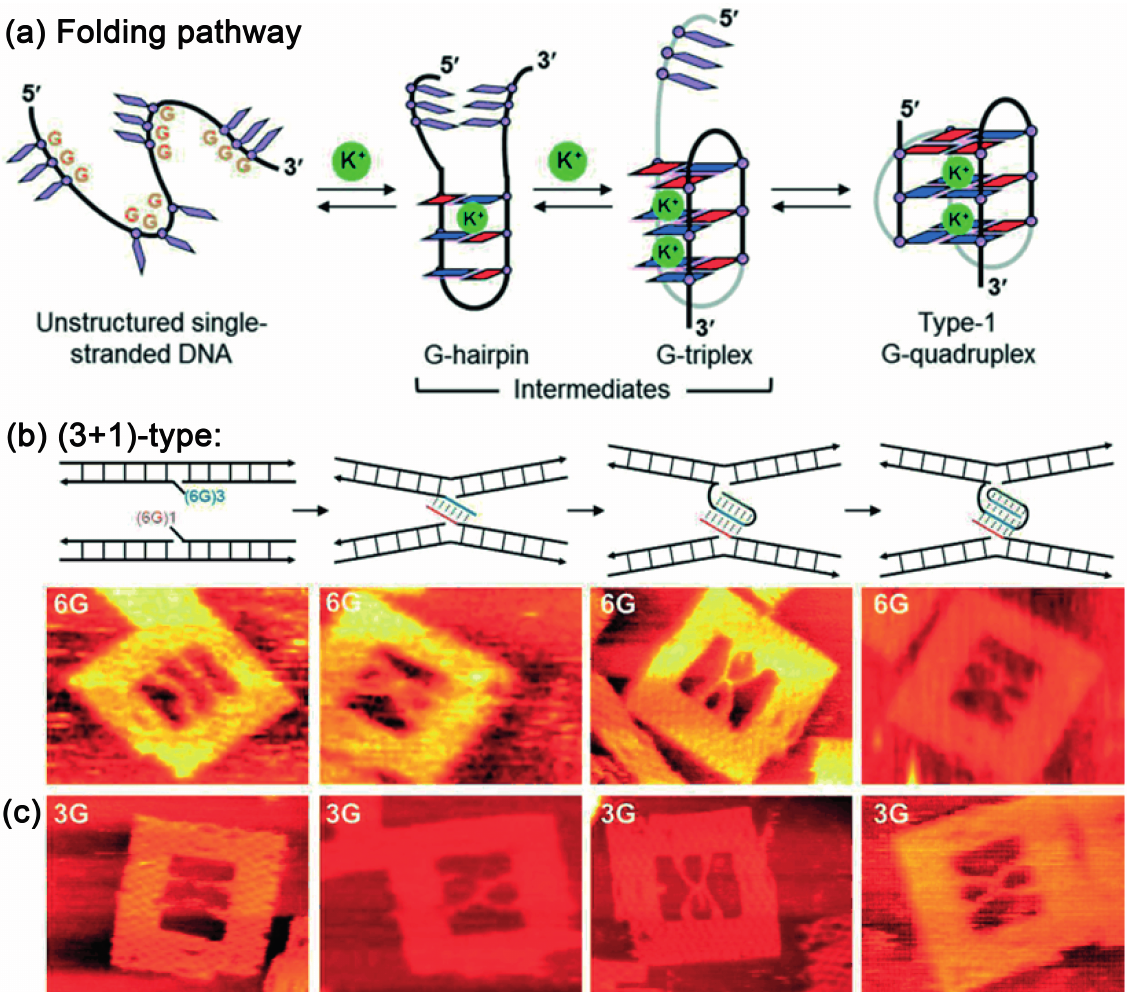
Figure 10. ( a ) Proposed folding pathway of the human telomeric type-1 G-quadruplex including the intermediates G hairpin and G triplex; ( b ) Scheme of different strand designs within the DNA origami frame that are able to form the G hairpin, G triplex, or a G quadruplex in presence of K + . Corresponding AFM images of the different designs show that without K + , but a (3+1)-type (6G in (b) and 3G in ( c )) design no G-quadruplexes are formed (parallel arrangement). In the presence of K + and using DNA strands capable of forming G hairpins, G triplexes, or G quadruplexes, respectively, the X shapes are observed. Adapted from Ref. [60]. Copyright Wiley VCH Verlag GmbH & Co